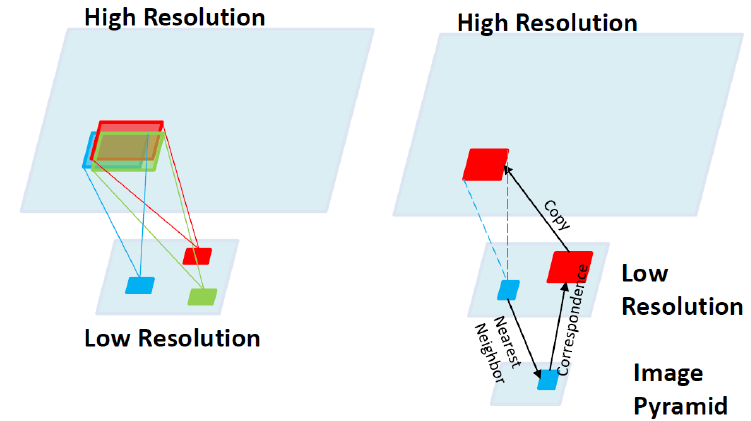
Figure 11. Example-based super-resolution using internal learning [8].